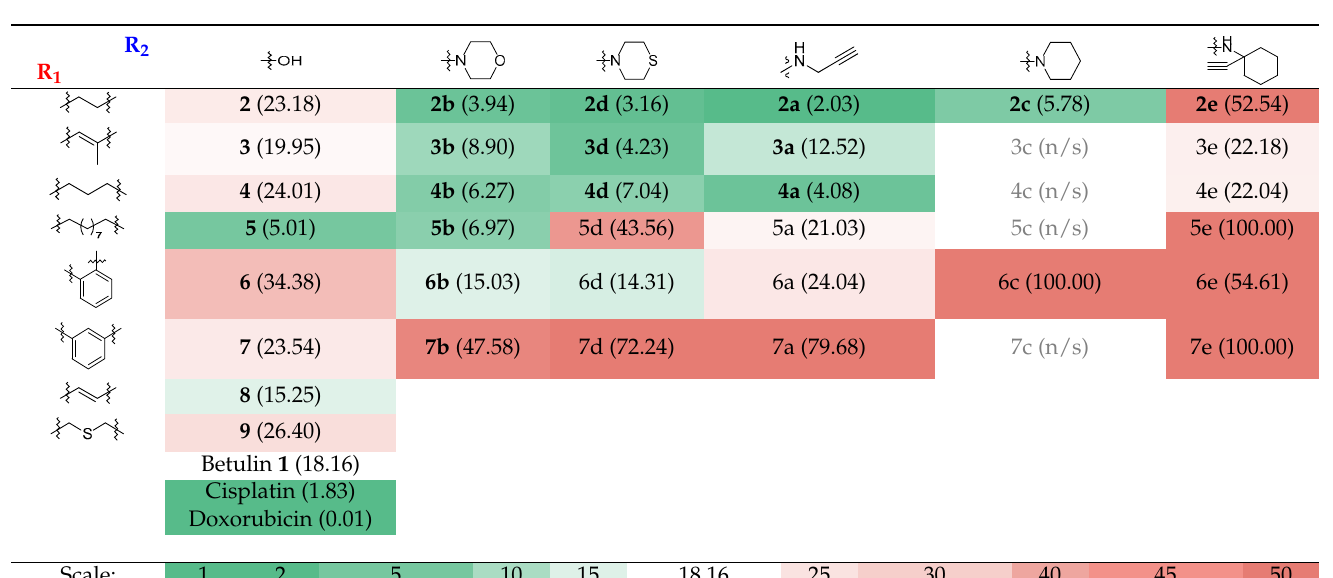
The color scheme visualizes active compounds in green and inactive ones in red. Color saturation corresponds to their degree of activity as indicated on the scale.